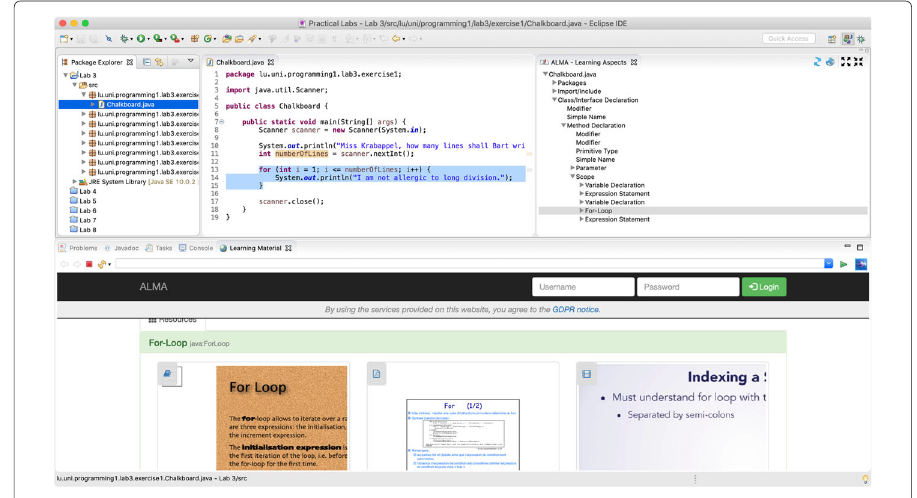
Fig. 2 ALMA Plugin for the Eclipse IDE